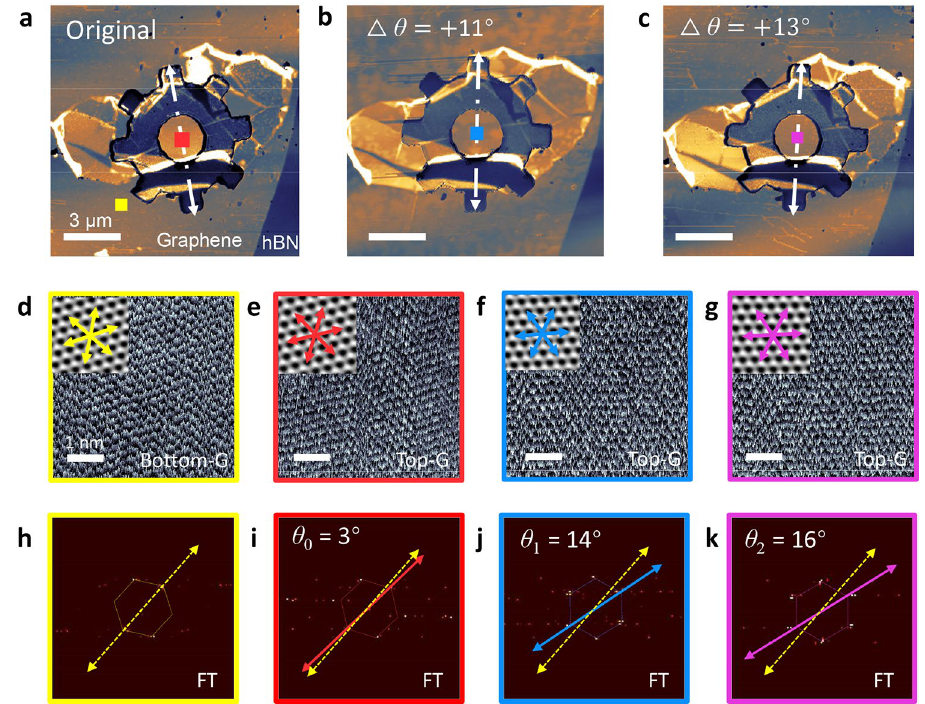
Figure 2. Manipulation of the twist angle. ( a – c ) Near-field infrared imaging of the same device at different twist angles. Δ θ indicate the angle change of the hBN gear relative to its original orientation. Scale bar: 3 μm. The dashed line arrows indicate a representative direction of the hBN gear. ( d ) High-resolution AFM image of the bottom layer graphene. Scale bar: 1 nm. The arrows indicate the zigzag direction of the graphene lattice. ( e–g ) High-resolution AFM images of the top layer graphene in the colored square regions in ( a – c ). ( h – k ) The 2D Fourier transform of figures ( d – g ). The twist angle θ between the bottom (yellow) and the top (others) layer graphene are 3°, 14°, 16°,